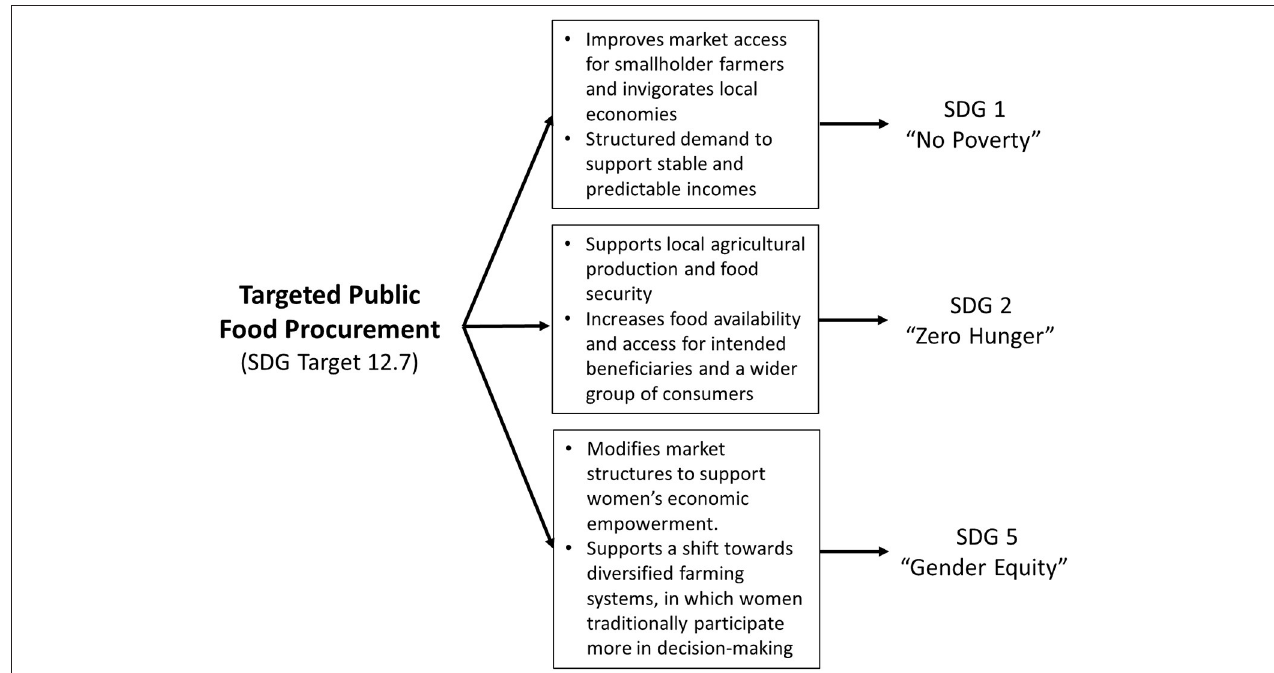
FIGURE 4 | Targeted public food procurement programs, such as Brazil’s National School Feeding Program, may contribute to sustainable consumption and production patterns (SDG 12, target 12.7). Targeted public food procurement may also support other Sustainable Development Goals, particularly SDG 1 “No Poverty,” SDG 2 “Zero Hunger,” and SDG 5 “Gender